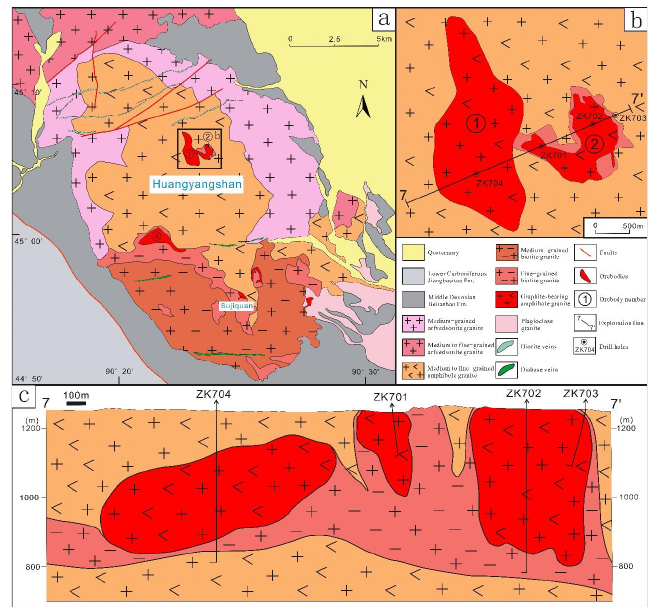
Figure 2. ( a ) Geological map of the Huangyangshan pluton; ( b ) simplified map of the No. 1 and 2 ore bodies of the Huangyangshan graphite deposit (after [2]); ( c ) cross-section along line 7 –7′ in Figure 2b (modified after [6]).